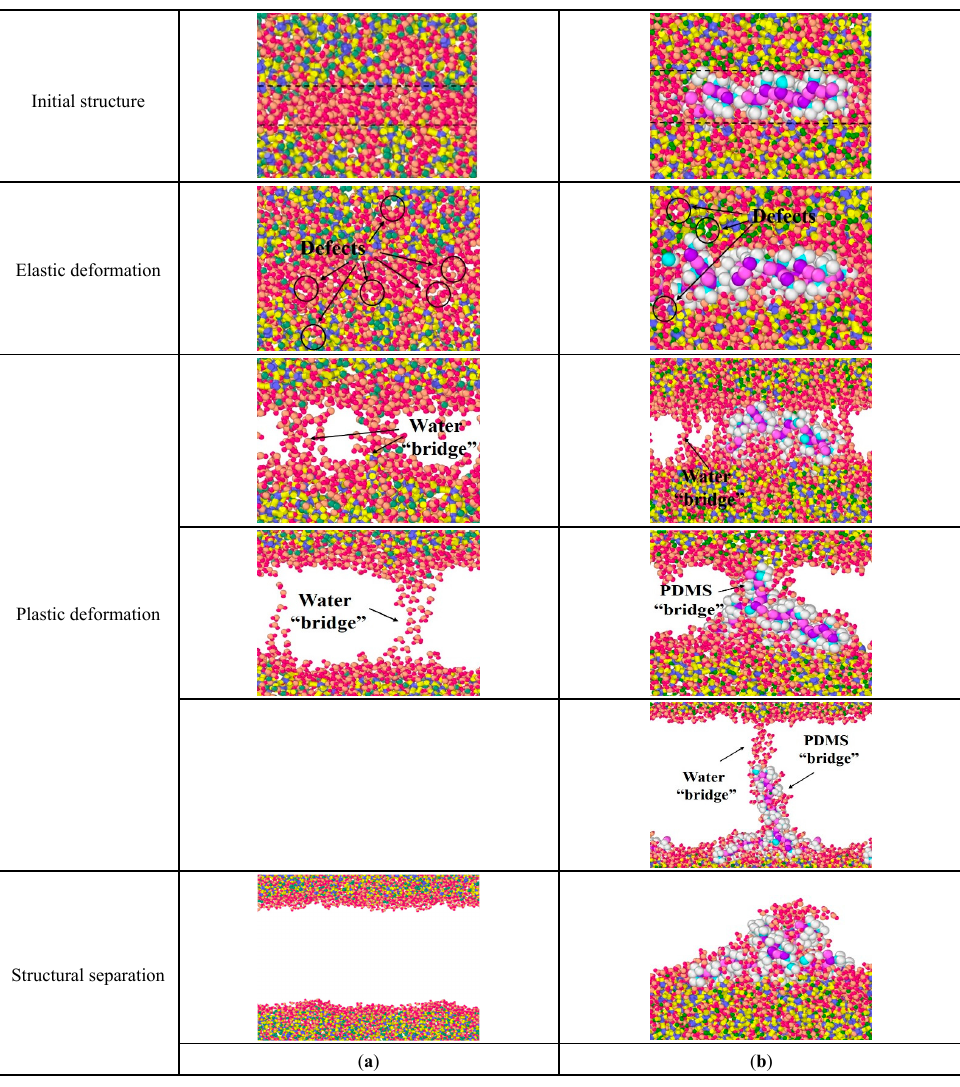
Figure 9. Structural changes of C-S-H stretched along the z-axis: ( a ) pure C-S-H; ( b ) PDMS-modified C-S-H.